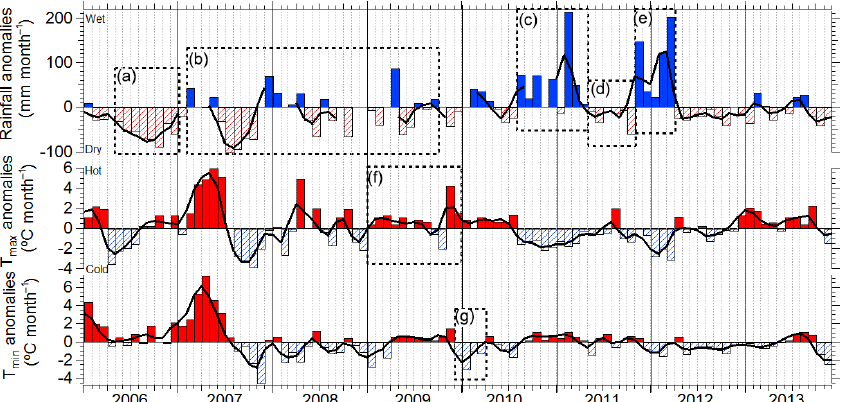
Figure 3. Monthly rainfall, minimum temperature ( T min ) and maximum temperature ( T max ) anomalies at Yarrangobilly Caves (BoM sta- tion 72141) during the cave drip-water monitoring study period. The solid line is the result of applying a binomial smoothing, one-pass Gaussian filter to the monthly